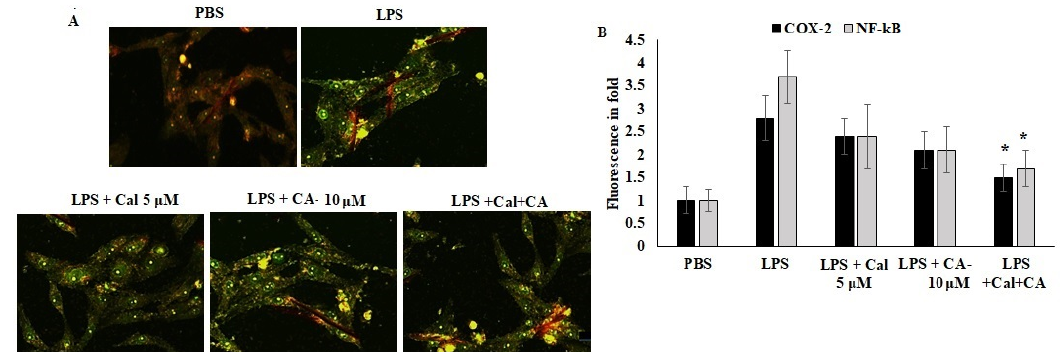
Figure 7. Immunofluorescence analysis of COX-2 and NF- κ B. ( A , B ) Immunofluorescence staining of HCT116 cell lines after 48 h of culture. Double staining for COX-2 and NF- κ B. Marker proteins were visualized under a fluorescent microscope: FITC (green, COX-2 and NF- κ B) and propidium iodide as counter stain (yellow nuclei). Original magnification 200 × . Data were obtained from three separate experiments and expressed as mean ± SEM. * p < 0.05 represents significance compared to treated group (CA and Cal) against PBS (untreated group